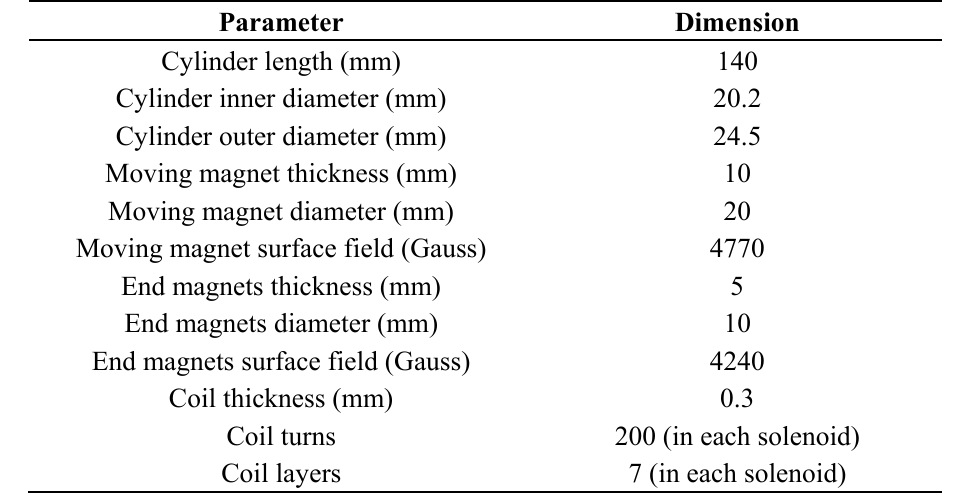
Table 1. Physical information of the participants.